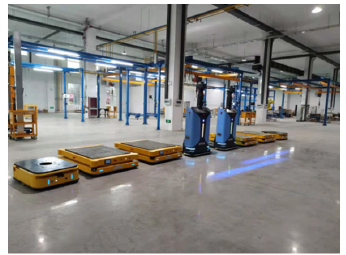
Fig.14. Transfer AGVs (yellow) and fork AGVs